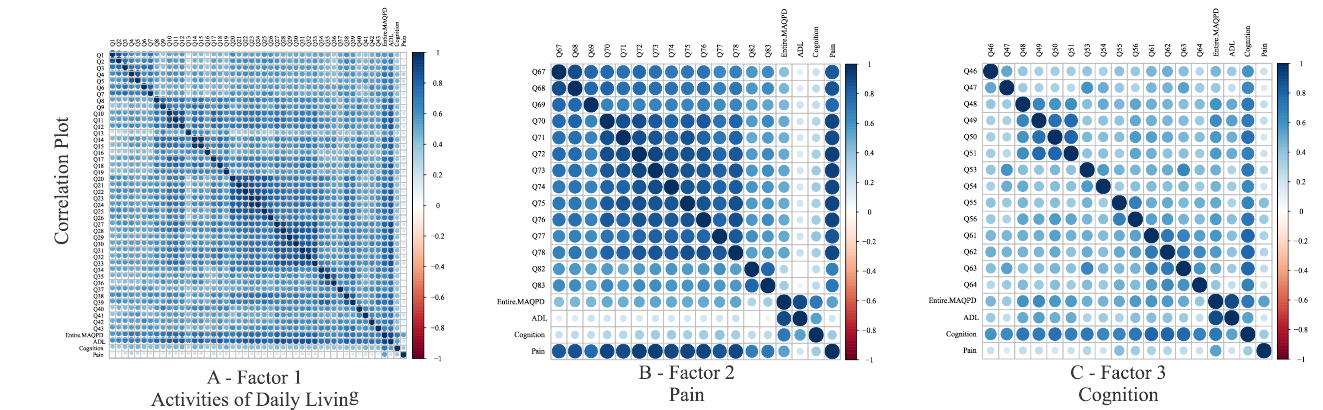
Figure 3. Correlation plots showing the correlation between variables of Factor 1 ( A ), Factor 2 ( B ), and Factor 3 ( C ), and the final scores.